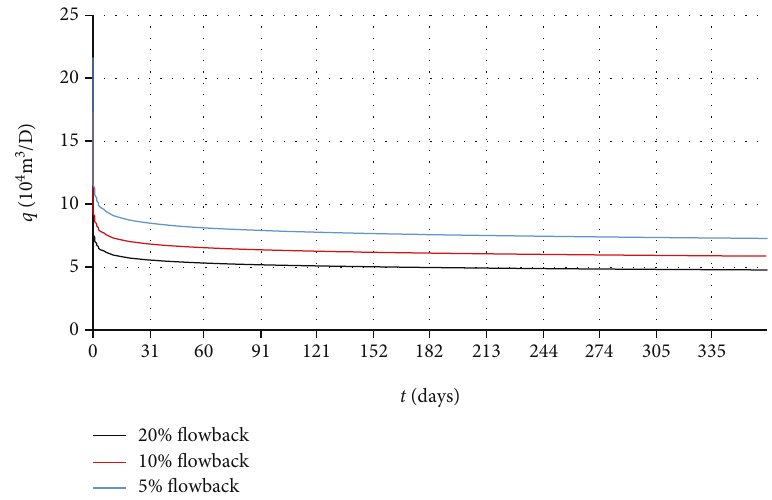
Figure 16: Change of gas production with time under di ff erent fl owback rates after